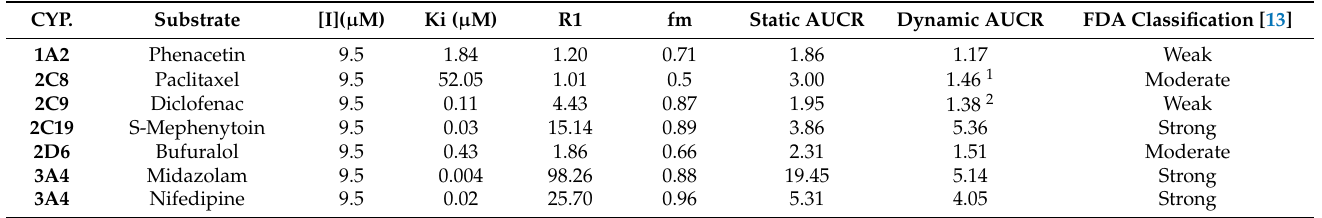
Table 6. Evaluation of the potential of dapaconazole as a CYP inhibitor through the predicted area under the curve ratios using a static and dynamic